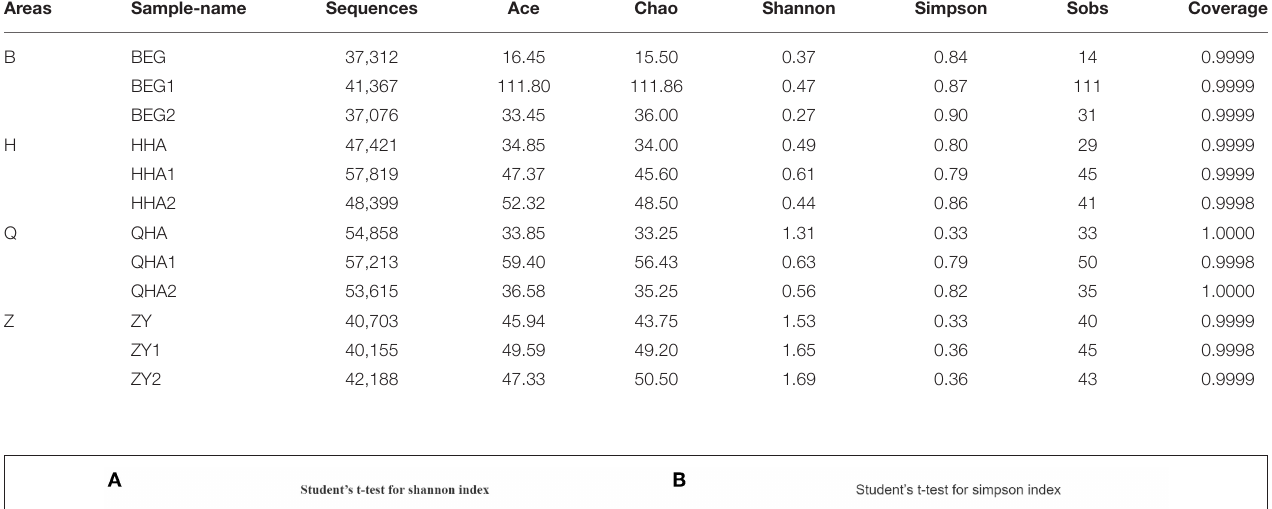
TABLE 1 | Sequence information and diversity value of 12 Hurunge samples. Areas